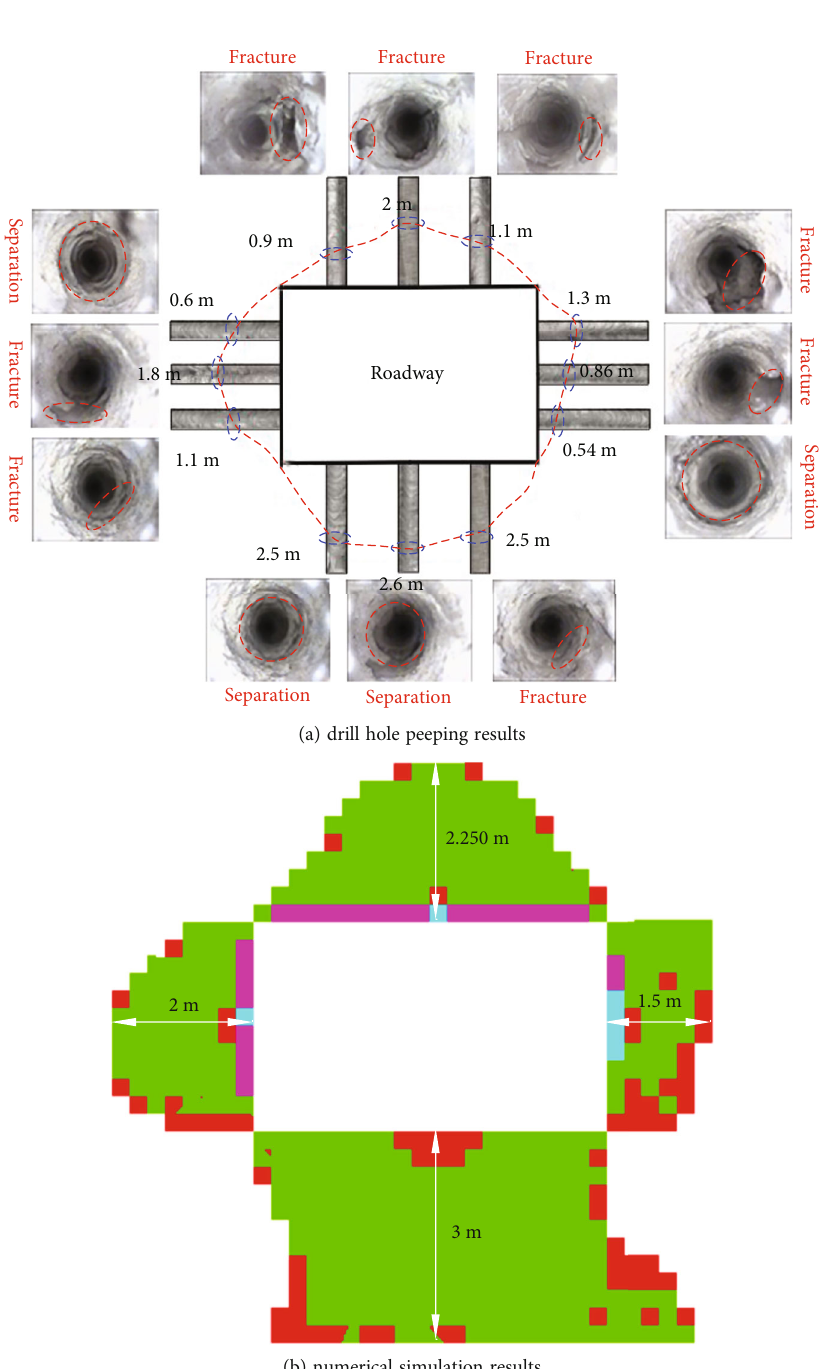
Figure 12: Comparison of the damage range of surrounding rock in 11030 transportation lane with the results of numerical